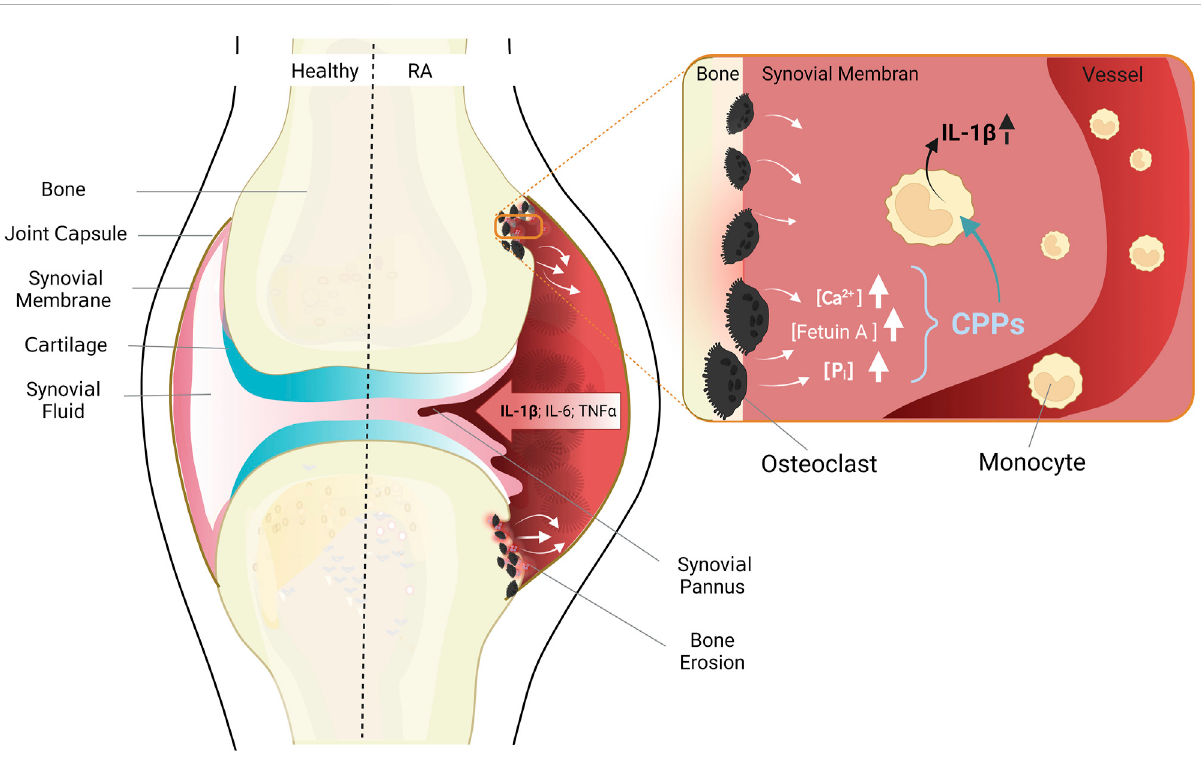
FIGURE 2 Anatomy of healthy joints (left) and pathological changes in RA (right). The healthy joint with joint capsule, synovial membrane consistent of a cell monolayer, cartilage and bone. RA leads to thickening of the synovial membrane due to immigrating immune cells, in fl ammatory cytokines are released,andcartilageandbonedestroyed.Enlargedcutout:situationinareasoferosiveboneresorption:Misdirectedactivationofosteoclastsleads to increased bone resorption, and release of high concentrations of the bone components calcium, phosphate, and fetuin-A. Monocytes migrate chemotactically from blood vessels into the synovial membrane, take up CPPs, and secrete pro-in fl ammatory cytokines, especially IL-1 β . Figure modi fi ed according to (Jäger et al., 2020) and created with